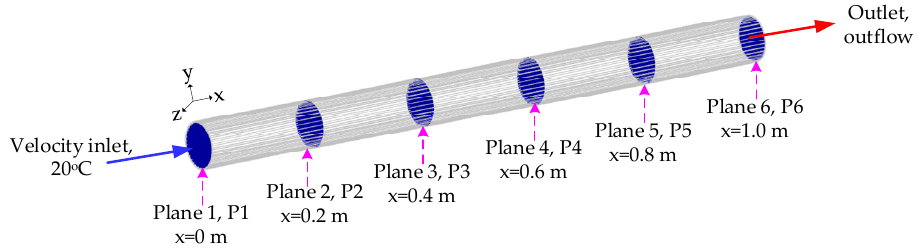
Figure 11. Schematic of the STC receiver in the SWH system. Table 3. Parameters in thermal performance of the four STCs.